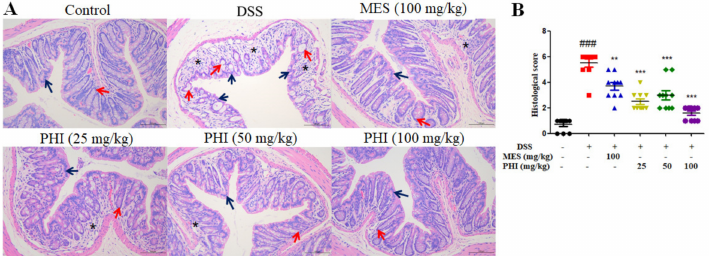
Figure 2. PHI improved the pathological damages of colon tissues. ( A ) Representative colon histolog- ical sections (scale bar = 100 µ m). ( B ) Colonic histological score. Asterisks referred to inflammatory cell infiltration. Blue arrows pointed to columnar epithelial cells while red arrows referred to crypts. ### p < 0.001 vs. control group. ** p < 0.01, and *** p < 0.001 vs. DSS group. ( n = 10 mice per